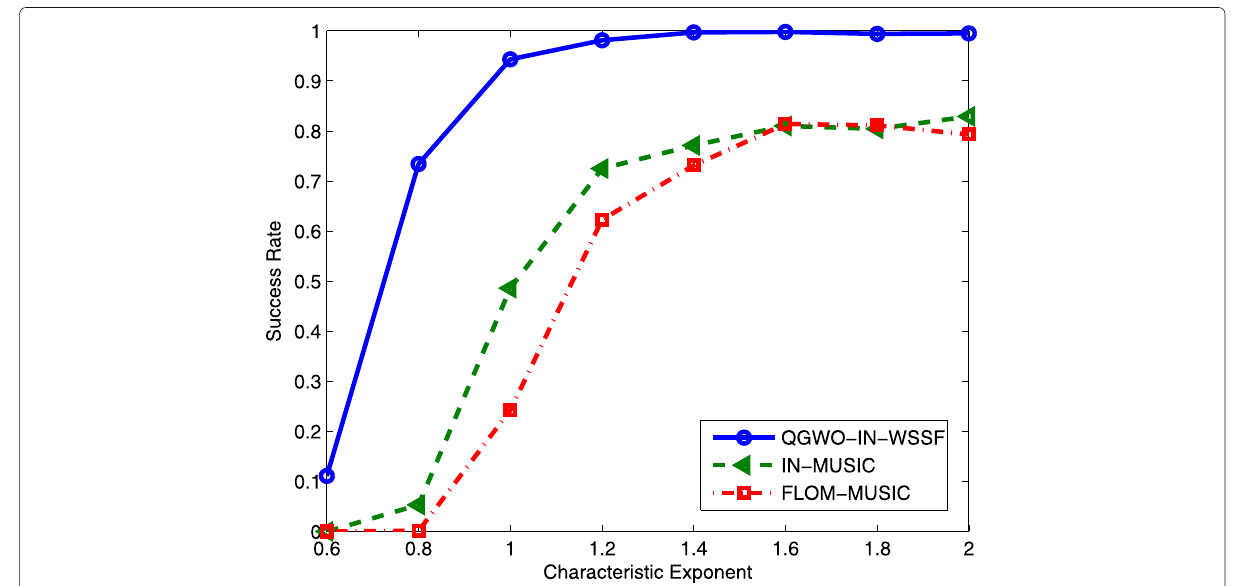
Fig. 9 Success rate curves versus characteristic exponent for three independent sources with GSNR = 20dB